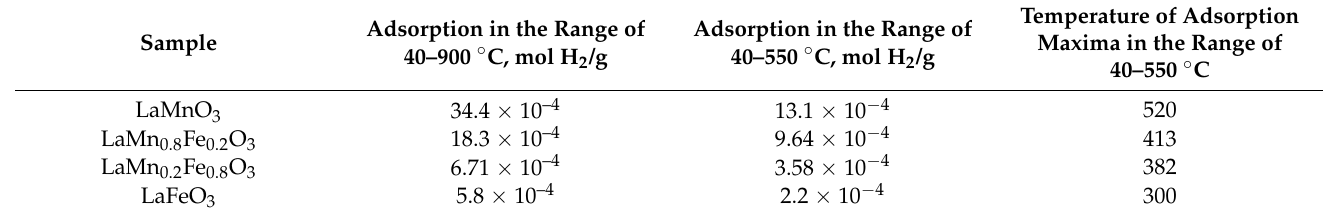
Table 3. Total (40–900 ◦ C) and low-temperature (40–550 ◦ C) hydrogen adsorption for LaMn 1 − x Fe x O 3